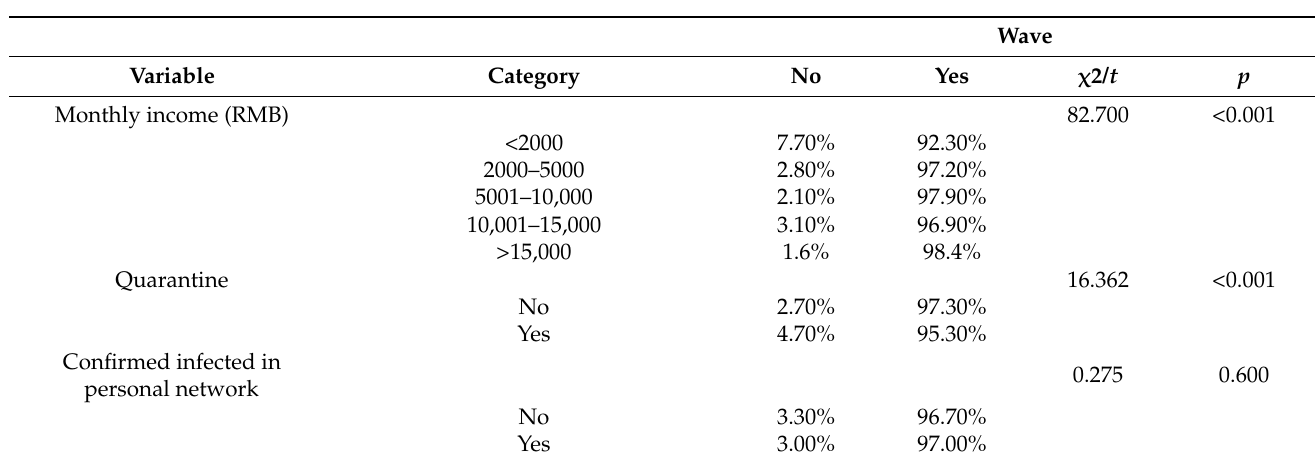
Figure 2. Comparison of the rate of wearing masks people with different education in two sur- veys.